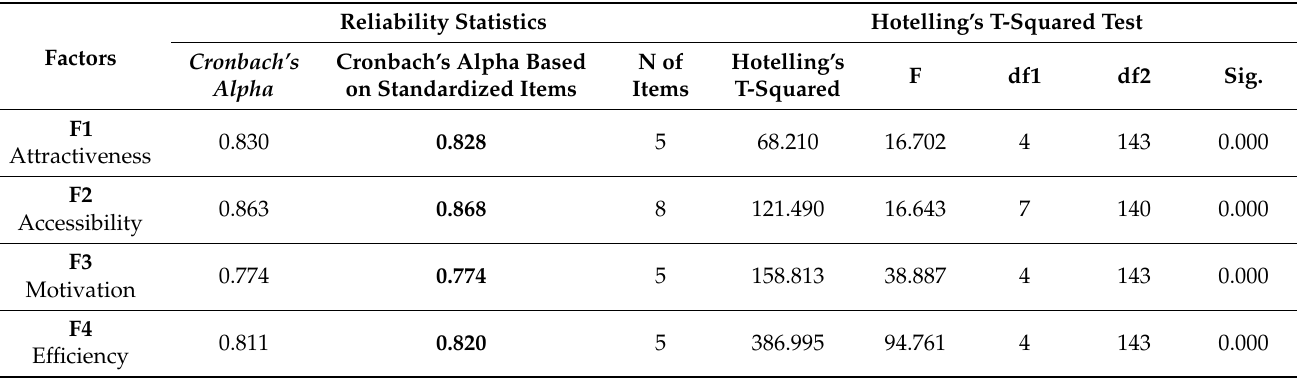
Table 1. The values of the fidelity coefficient and the test of equality of the averages for the answers to the items of the 4 factors of the questionnaire ( N = 147).